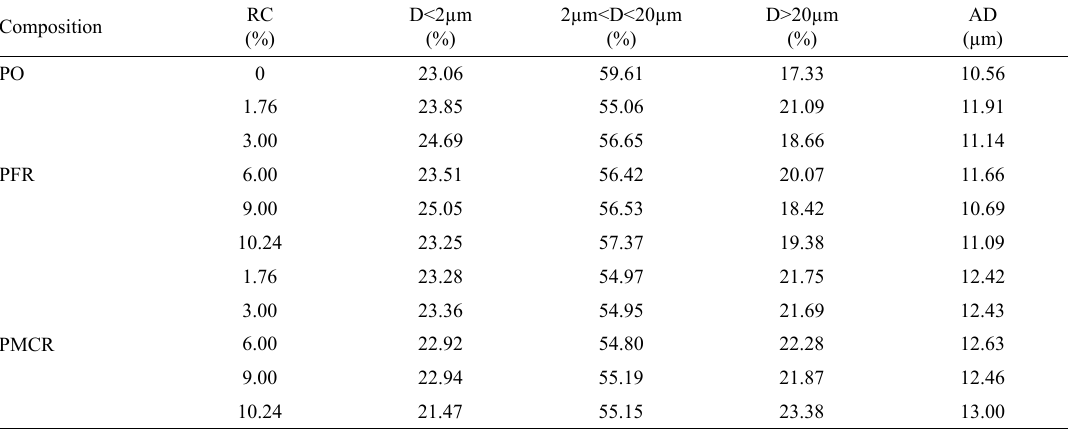
Figure 1. XRD spectra of the porcelain ceramic mass and compositions with 10.24 wt.% of quartzite residues, FR and MCR. D - Dolomite; Table 3. Average diameter (AD) and volumetric fraction for diameters (D) below 2 µm, between 2 and 20 µm and above 20 µm, for the porcelain ceramic mass (PO) and compositions with fine quartzite residue (PFR) and milled coarse quartzite residue (PMCR).